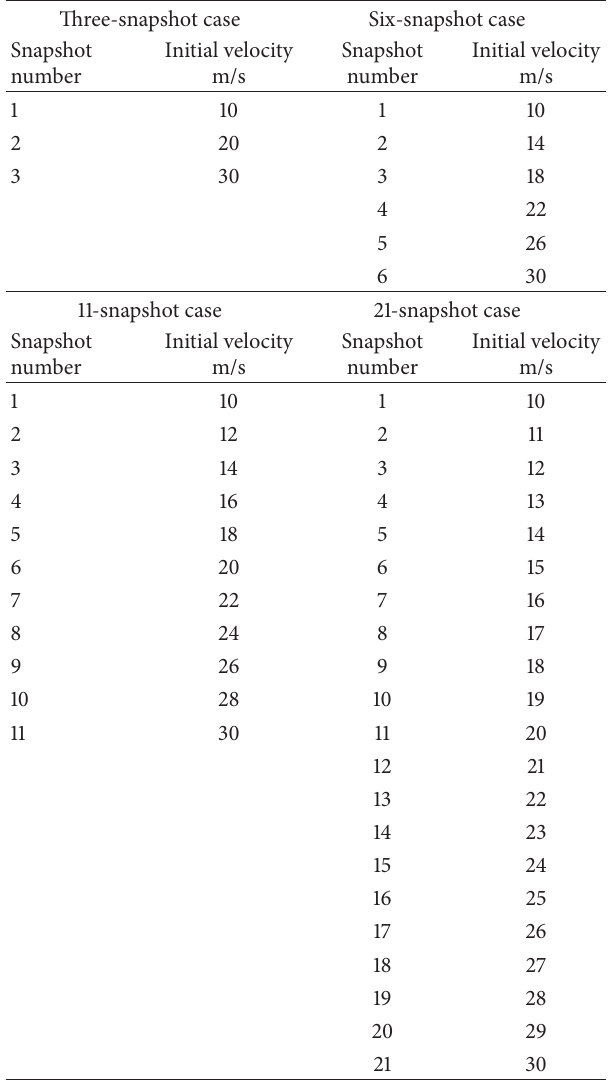
Table 1: Backward facing step. Summary table of the snapshot